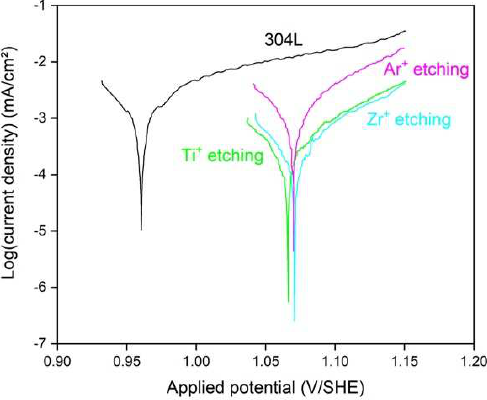
Figure 8. Potentiodynamic polarization curves of raw and etched 304L steel in a nitric acid solution at boiling temperature after 48 h of immersion. Black: initial 304L; violet: Ar + etching; green: Ti + etching; cyan: Zr + etching. Table 2. Corrosion potential (E corr ) and current density (J corr ) values after 48 h of immersion in a nitric acid solution at boiling temperature.